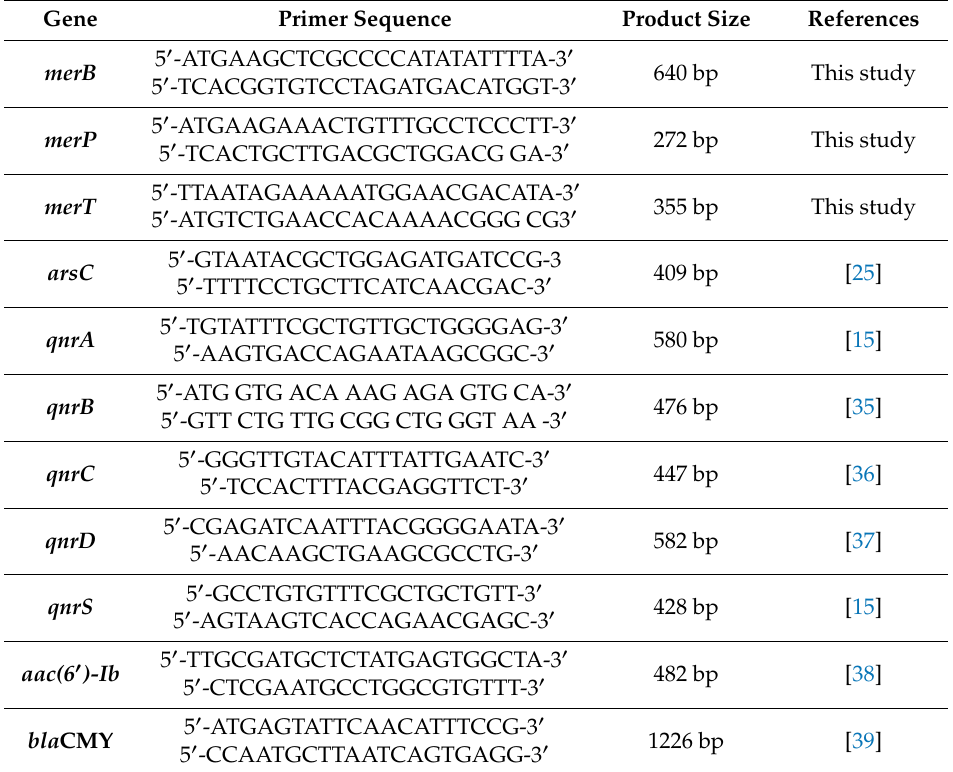
Table 1. Primers used for amplification of di ff erent